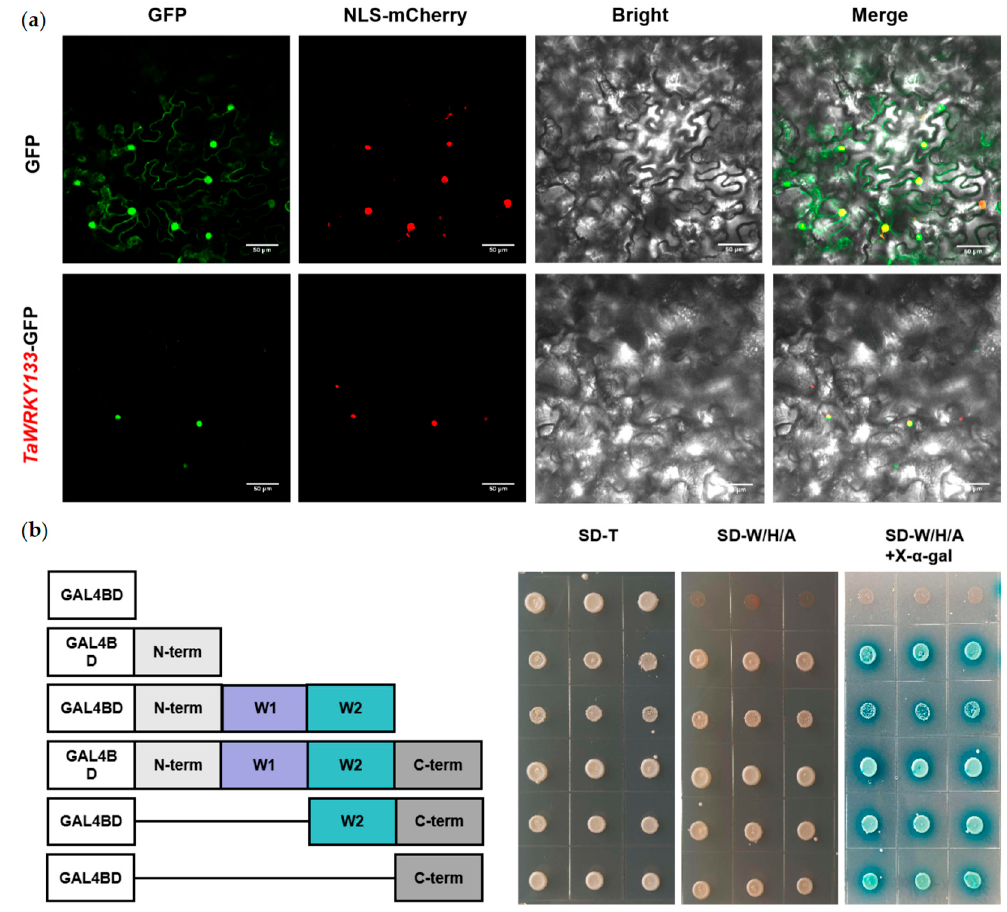
Figure 3. Subcellular location and transcriptional activation assay of TaWRKY133 . ( a ) Subcellular localization of TaWRKY133. The bacterial liquid containing the target plasmid was injected into tobacco leaves for observation using a 40× laser confocal microscope, and the length of the scale bar is 50 μ m. ( b ) Transcriptional activation assay of TaWRKY133 . An empty pGBKT7 vector was used as a negative control.